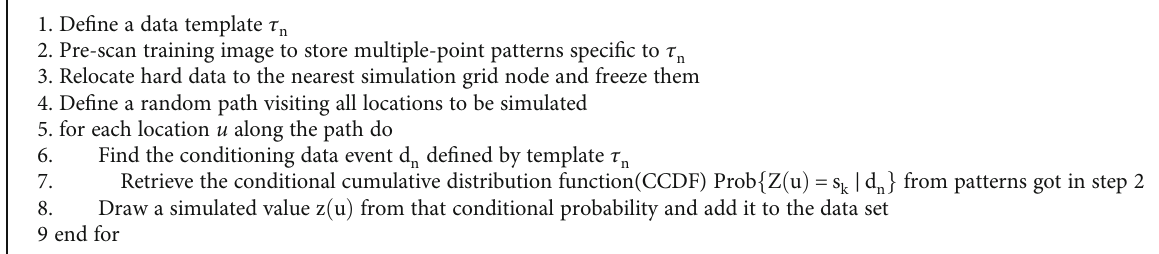
Algorithm 1: Multiple-point statistics simulation of a single